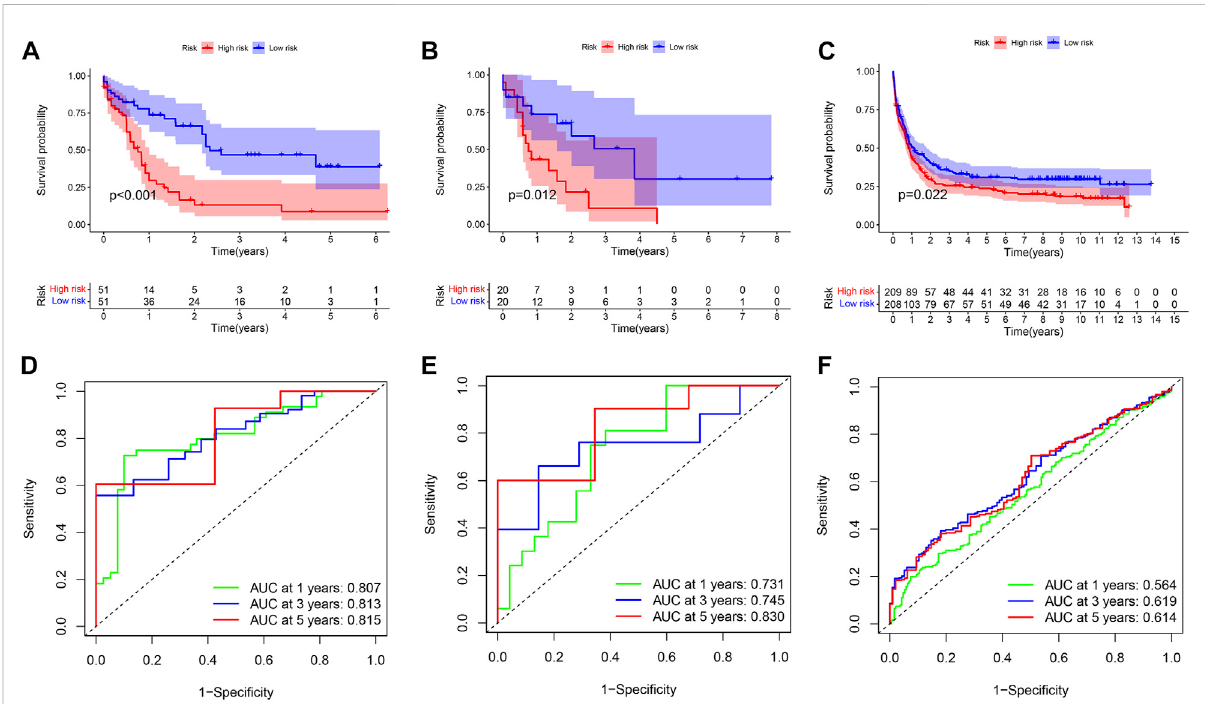
FIGURE 4 UnivariateCoxregressionanalysisandprognosiscurve. (A) KMcurveoftrainset. (B) KMcurveoftestset. (C) KMcurveofGEOexternalvalidation set. (D) ROC curves ofmodel for predicting the1/3/5-yearssurvival inthe train set. (E) ROC curves of model for predicting the 1/3/5-years survival in the test set. (F) ROC curves of model for predicting the 1/3/5-years survival in the GEO external validation